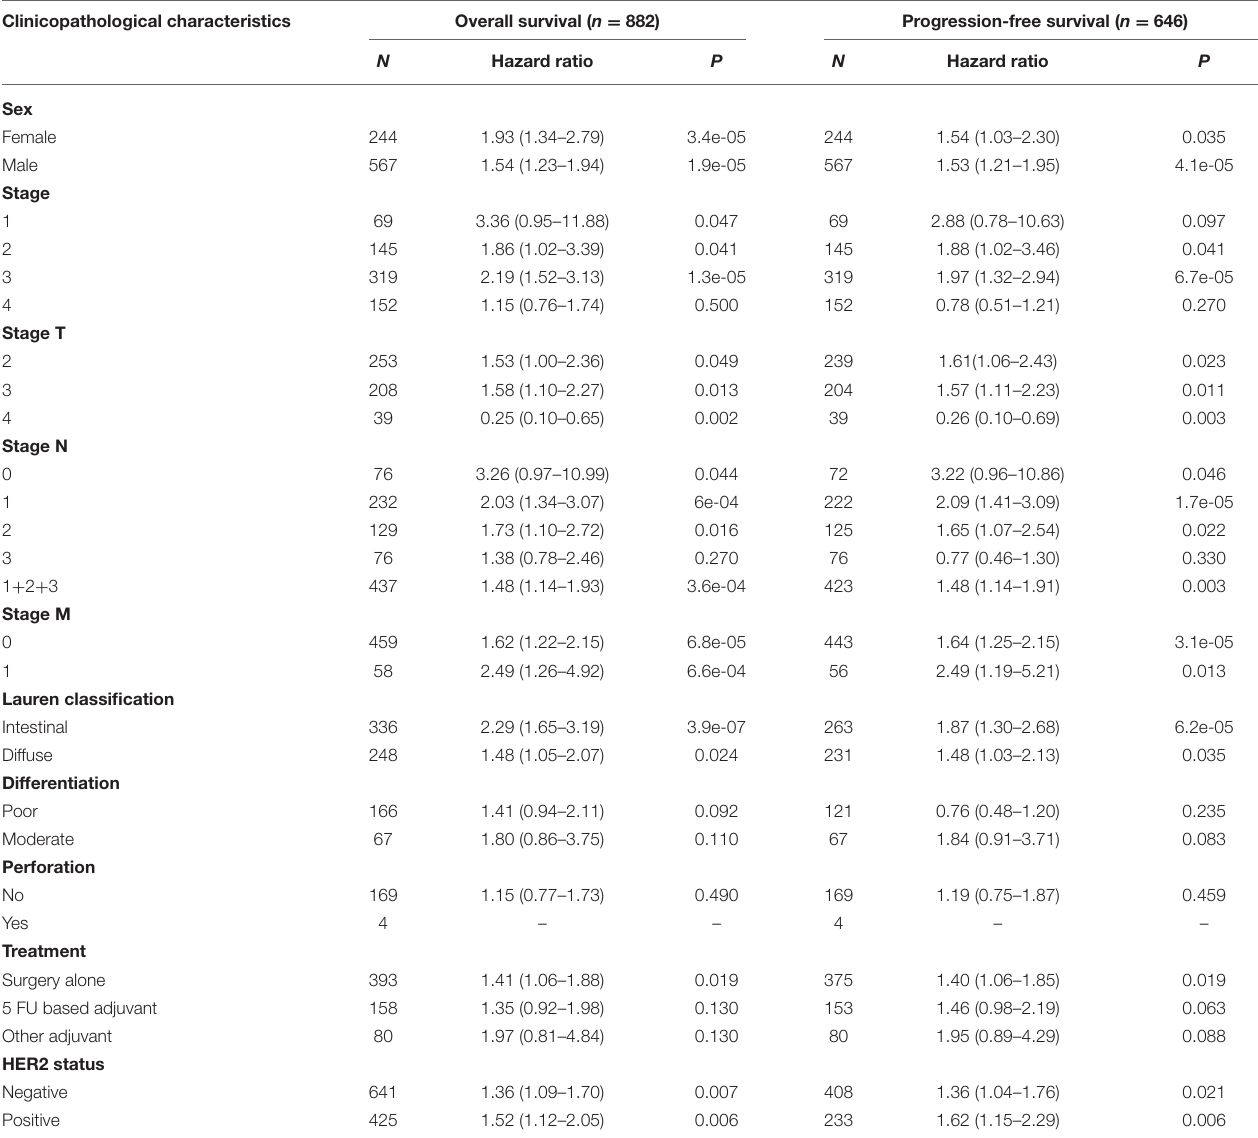
TABLE 1 | Correlation of TIM1 mRNA expression and clinical prognosis in gastric cancer with different clinicopathological factors by Kaplan-Meier plotter (GSE62254, GSE14210, GSE15459, GSE22377, GSE29272, GSE51105). Clinicopathological